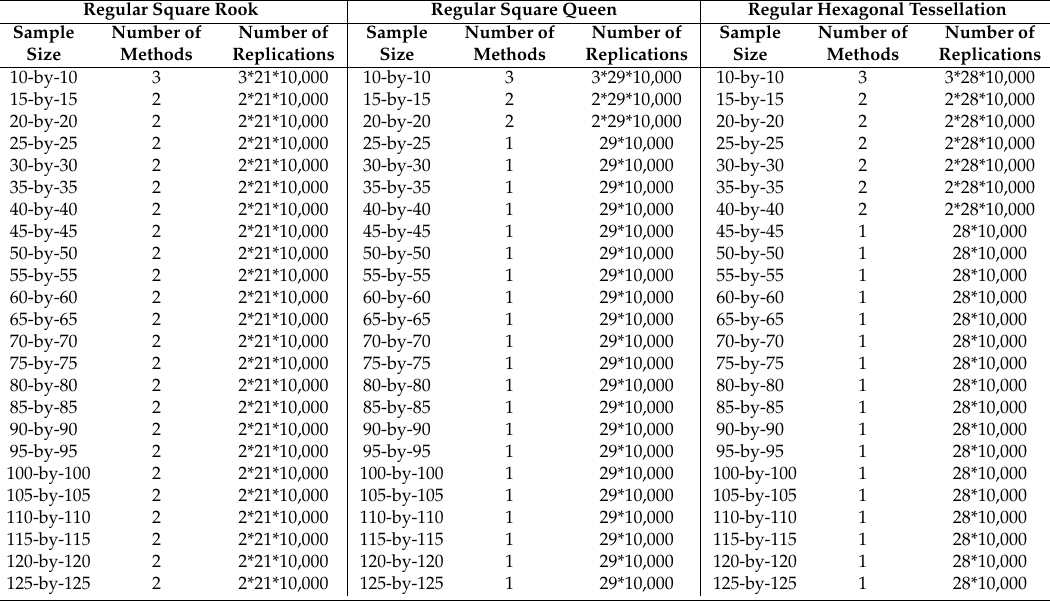
Table A2. Simulation experiments employing ρ within its feasible